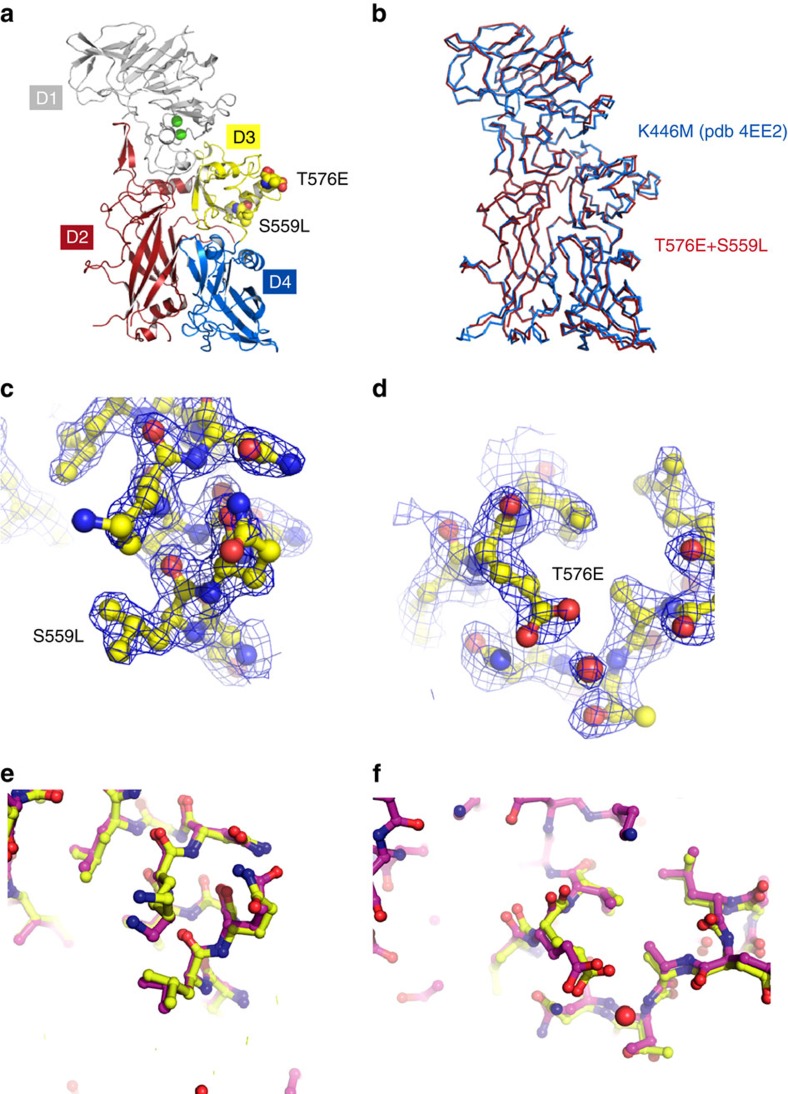
Comparison of the structure of WT and mutant PA.(a) Cartoon presentation of APA T576E/S559L. D1, grey is calcium-binding domain. D2, red is membrane insertion and heptamerization domain. D3, yellow is heptamerization domain. D4, blue is receptor binding domain. The positions of the mutated residues are shown in sphere representation. The two green spheres represent calcium ions. (b) Superposition of APA T576E/S559L with the published structure of K446M (pdb code 4EE2). The rmsd is 0.78 Å for 675 aligned residues. (c,d) Experimental electron density maps around S559L and T576E. The blue mesh is a 2FoFc map contoured at a sigma level of 1. The protein is shown in ball and stick representation. (e,f) Superposition of the crystal structure (yellow) and predicted structure by FoldX (magenta).